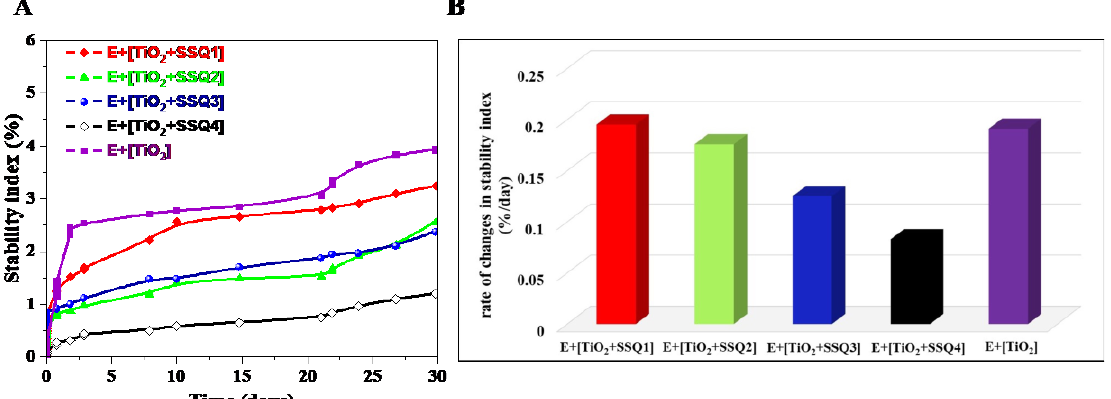
Figure 12. Stability indexes ( A ) and rate of changes in stability index ( B ) for emulsions Figure E+[TiO 2 +SSQ1], E+[TiO 2 +SSQ2], E+[TiO 2 +SSQ3], E+[TiO 2 +SSQ4], E+[TiO 2 ].